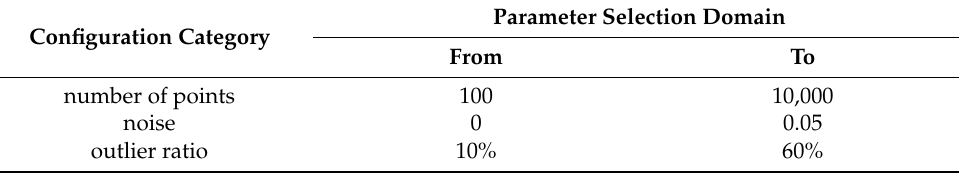
Table 1. Domain of parameters used to simulate spheres (inliers) and tangential planes (outliers).